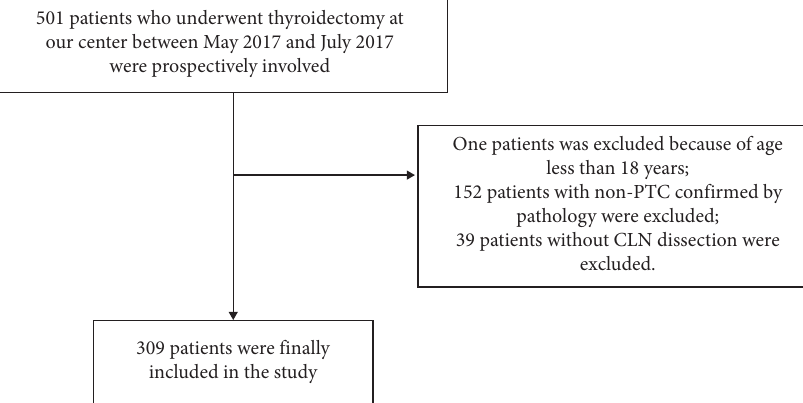
Figure 1: The flow chart of selection of papillary thyroid carcinoma patients. Table 1: The demographic and baseline features and status of central lymph node metastases in 309 patients with PTC.